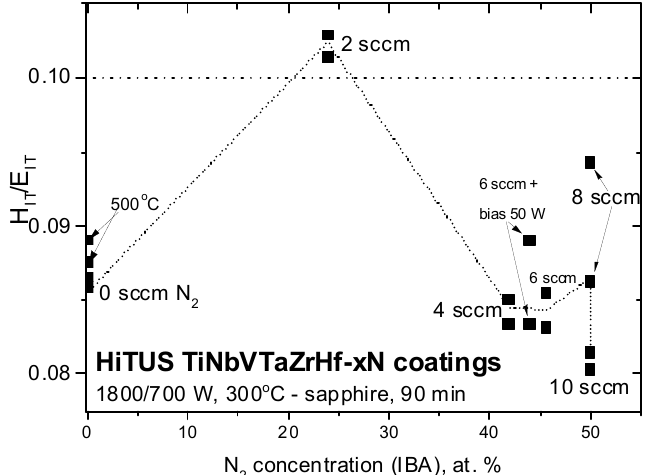
Figure 14. The dependence of H IT /E IT ratio on nitrogen concentration in the studied reactive HiTUS TiNbVTaZrHf-xN coatings.